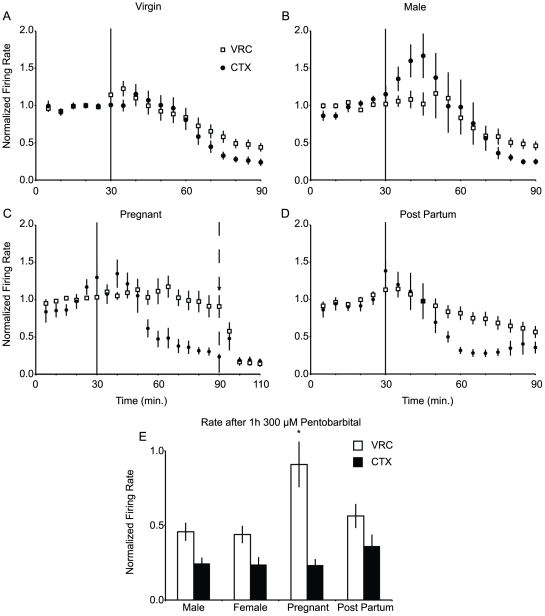
Neuronal responses to pentobarbital are altered in the medulla but not cortex of pregnant animals.Spontaneous activity of neurons in the VRC including rVRG, PreBötC, and BötC are insensitive to pentobarbital (300 µM) during pregnancy. A, Mean normalized firing rate of VRC (n = 37 closed circles) and CTX (n = 47, open squares) neurons from virgin female rats (n = 5 animals) in response to 300 µM pentobarbital (applied at vertical bar, t = 30 min). B, Pentobarbital had equivalent effects on VRC (n = 62) and CTX (n = 37) neurons from male rats (n = 6 animals). C, Pentobarbital (solid vertical line) failed to depress spontaneous activity of VRC neurons (n = 31) from pregnant animals (n = 4), yet inhibited CTX neurons (n = 26) in the same animals. Neuronal activity was modulated by barbiturate insensitive GABAARs, as 20 µM muscimol (dashed vertical line) rapidly silenced VRC neurons. D, This effect is reversible as both VRC (n = 51) post partum animals (n = 4) were inhibited by pentobarbital. E, Quantification of the normalized spontaneous activity of CTX (filled bars) and VRC (open bars) after 60 min of pentobarbital (300 µM) application. Single unit activity was normalized to mean baseline activity for that neuron (time 0–30 min). * denotes significantly different from virgin female. p<0.05.